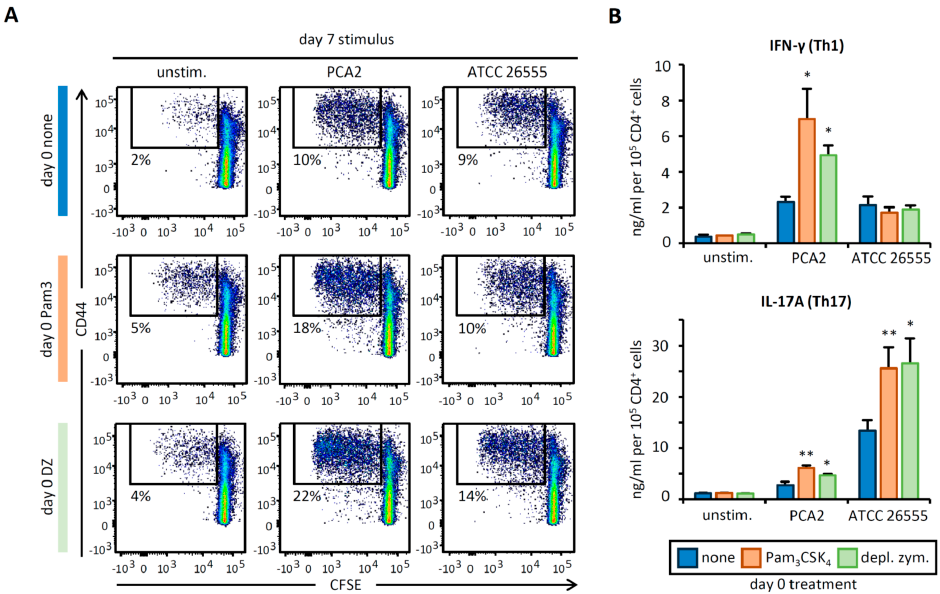
Figure 4. C. albicans -stimulated APCs derived from Pam 3 CSK 4 - or depleted zymosan-exposed HSPCs prime enhanced Th1 and Th17 responses in CD4 T cell cocultures. APCs obtained as in Figure 3 were cocultured with CFSE-labeled CD4 T cells isolated from naïve C57BL / 6 mice at 1:5 ratio (APC:T cell). Following 4 days of coculture, T cells were harvested for ( A ) flow cytometry analysis of proliferating CD4 + T cells expressing CD44 and ( B ) cytokine production (IL-17A and IFN- γ ) after 24 h of restimulation with PMA and ionomycin. Cytokinedata were normalized by CD4 Tcell numbers (shown in Figure A2C) and represent means ± SD of triplicate cultures, * p < 0.05, ** p < 0.01 with respect to day 0. Results shown are from one experiment representing three independent